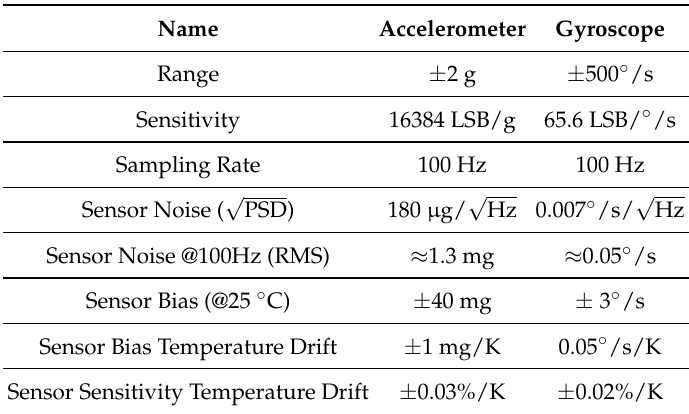
Figure 7. MetaMotion C Sensor Board: From left to right: (1) Coordinate frame of MetaMotion C sensor board (this is the body frame of our algorithm); (2) 3D-printed MetaMotion C case; (3) MetaMotion C PCB; (4) The IMU (inside the case) is mounted to the thorax of the biobot with the +Y direction of the IMU facing in the direction of the biobot’s antennae. Table 5. BMI160 specifications and performance